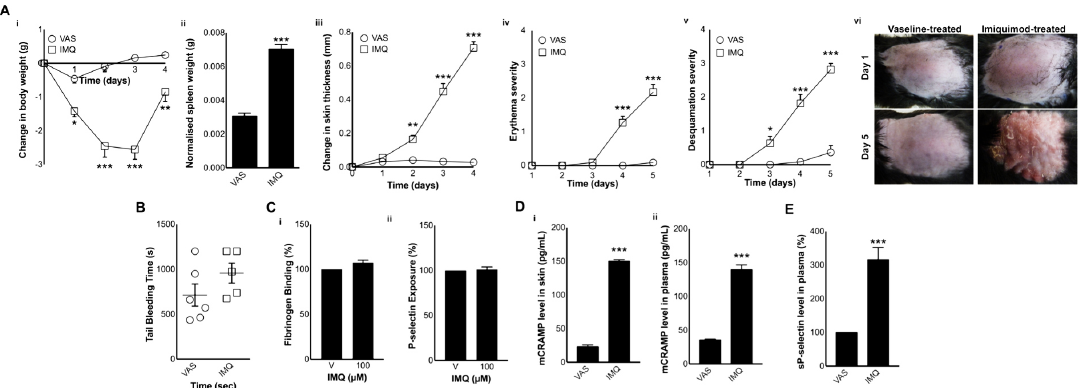
Figure 1. The characterisation, haemostasis, and the expression of mCRAMP in psoriatic mice. ( A ) Characterisation of a psoriasis mouse model was performed by measuring the body weight (Ai), spleen weight (Aii), and skin thickness (Aiii) in Imiquimod (IMQ)-treated mice compared to the